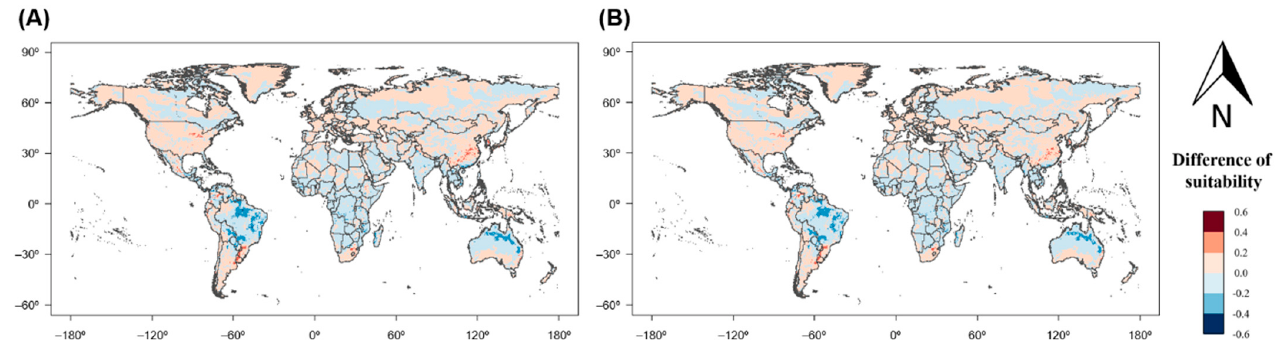
Figure 5. Changes in climatic suitability for S. geminata under global warming between current conditions and 2050 based on ( A ) scenario A1B and ( B ) scenario A2.